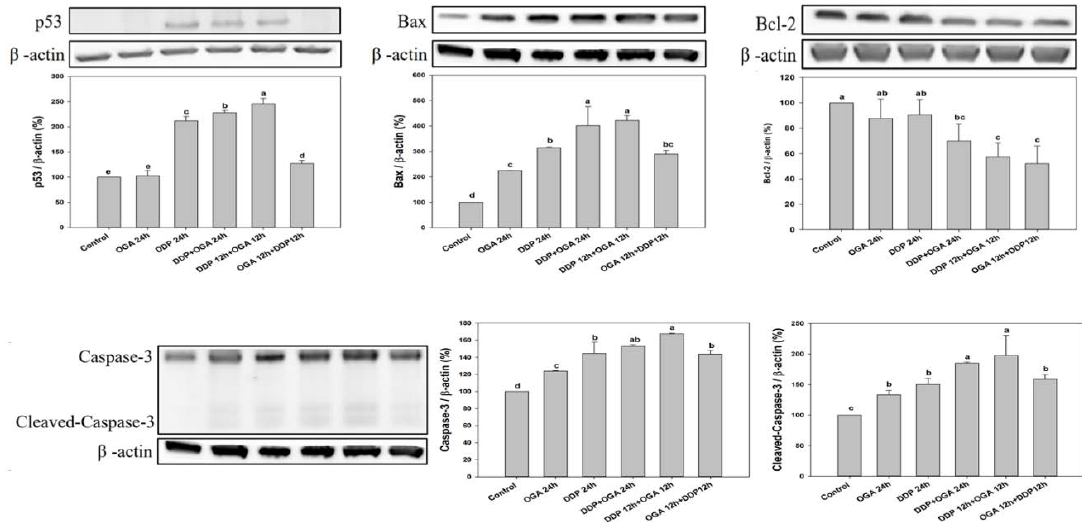
Figure 5. Apoptosis effect of OGA and DDP on human lung cancer cells (A549). A549 cells were treated with 100 μg/mL of OGA or 2 μg/mL of DDP at 37 °C for 24 h, followed by Western blot analysis. p53, Bax, Bcl-2, Caspase-3, and Cleaved-Caspase-3 were examined by Western blot analysis. Values are expressed as means ± SD of three measurements. Means bearing the same superscript small letters in the same row are not significantly different ( p > 0.05). DDP: cisplatin (2 μg/mL), OGA: oligogalacturonides (100 μg/mL).